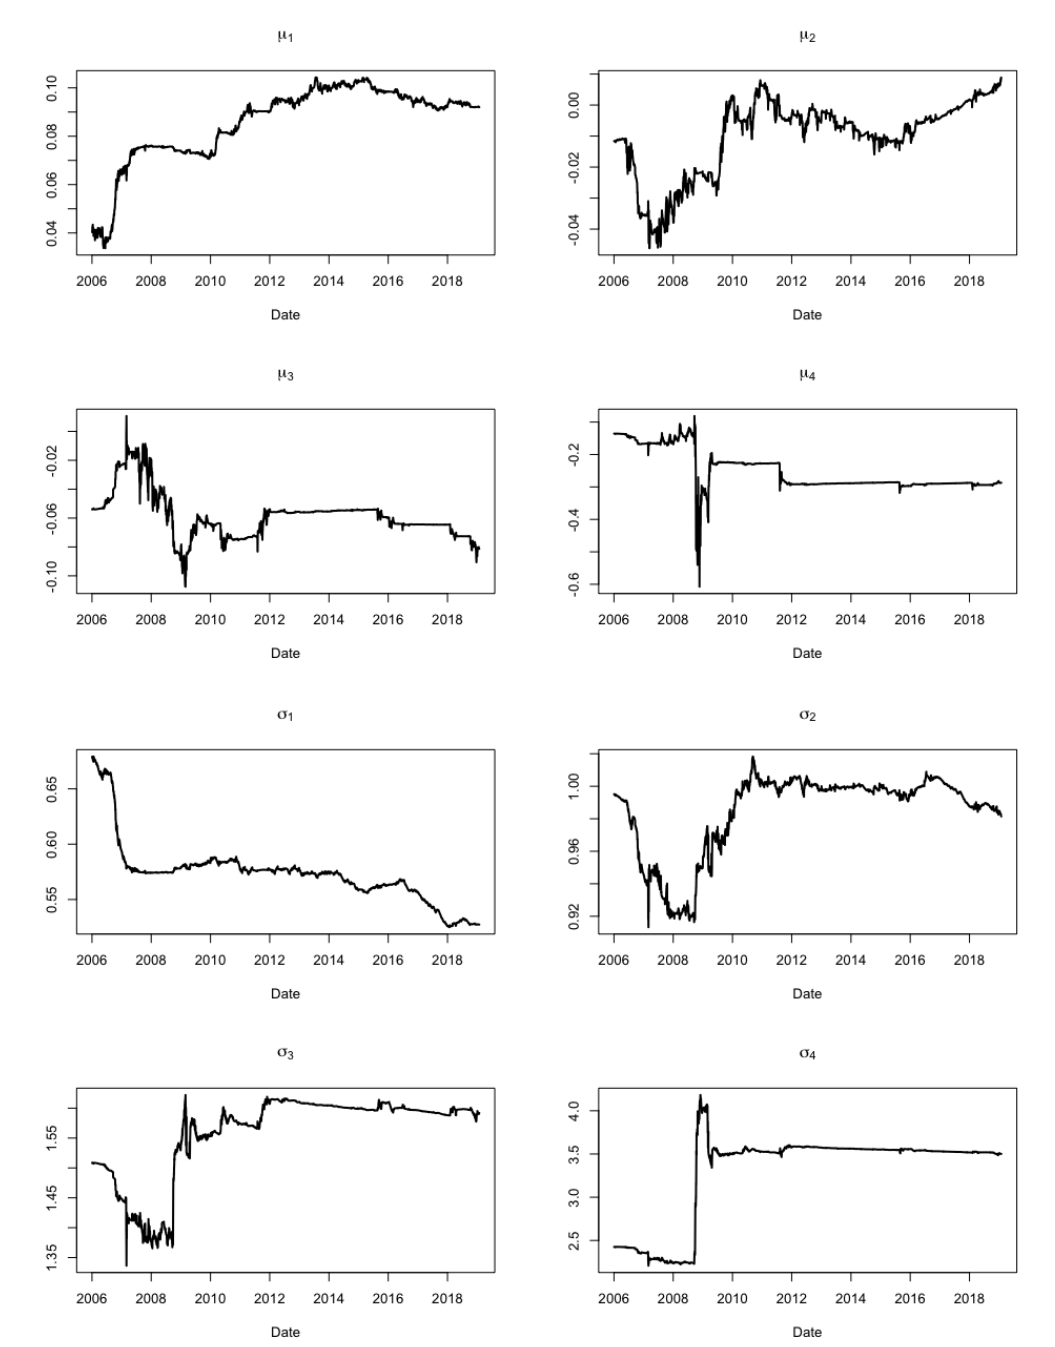
Figure 15. Expanding window: state-dependent means and volatilities for the homogeneous four-state normal HSMM on S and P 500 daily log